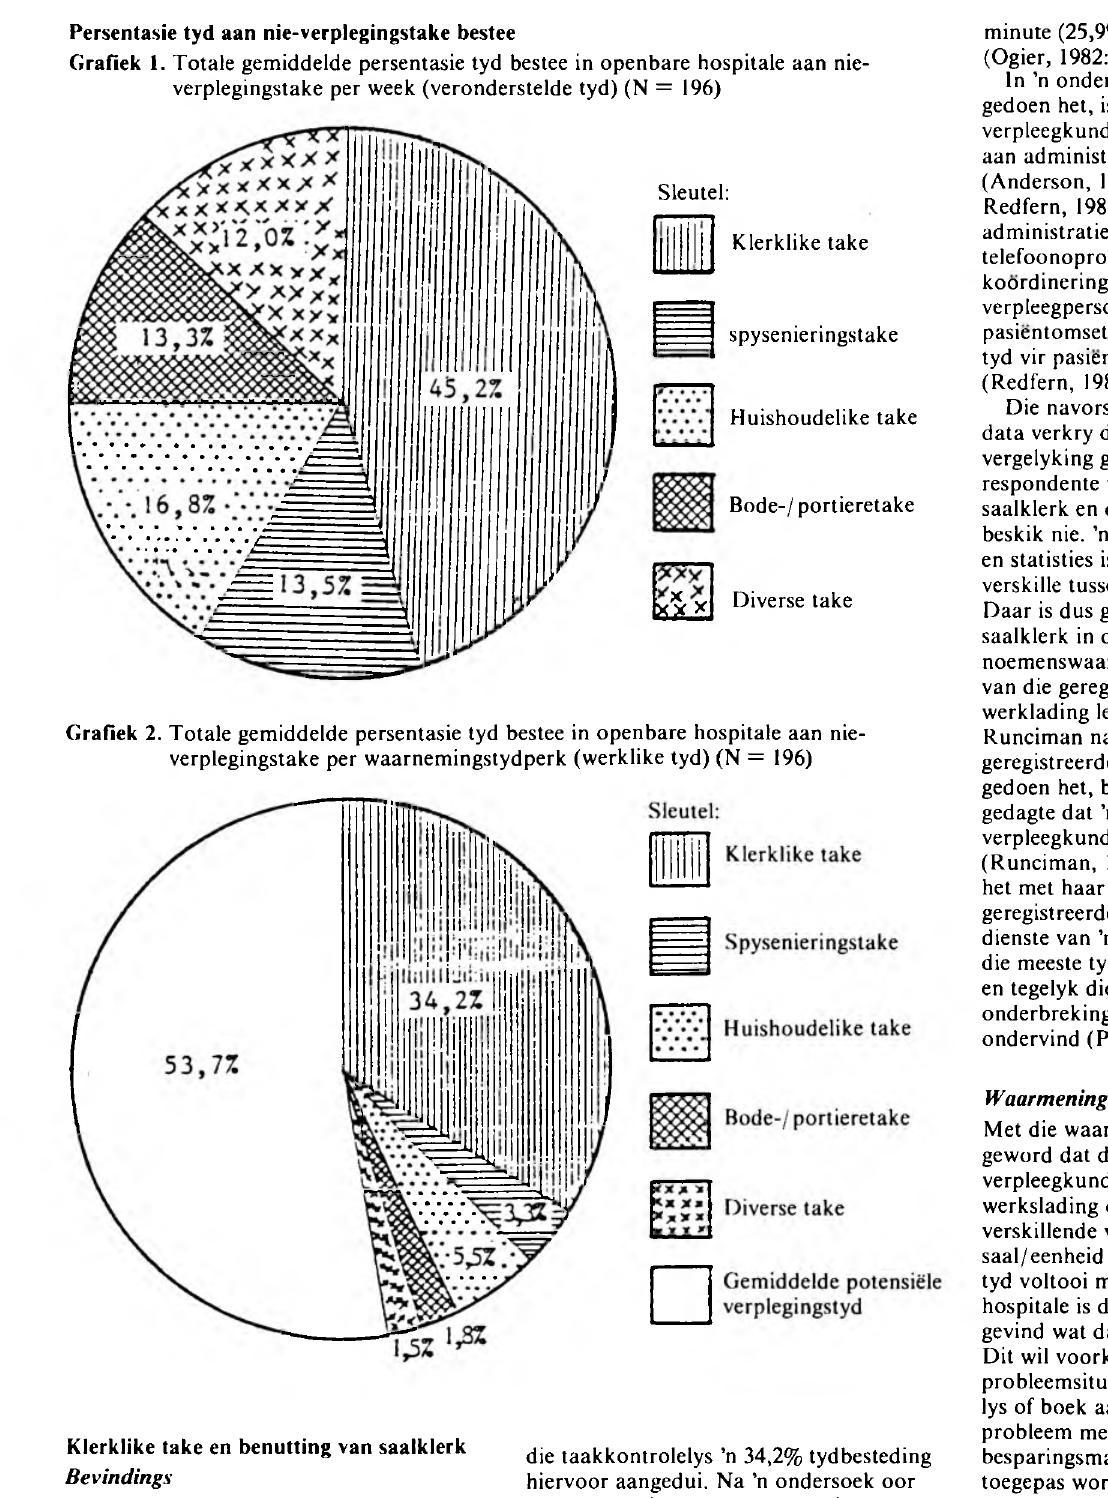
Grafiek 1. Totale gemiddelde persentasie tyd bestee in openbare hospitale aan nie- verplegingstake per week (veronderstelde tyd) (N = 196)